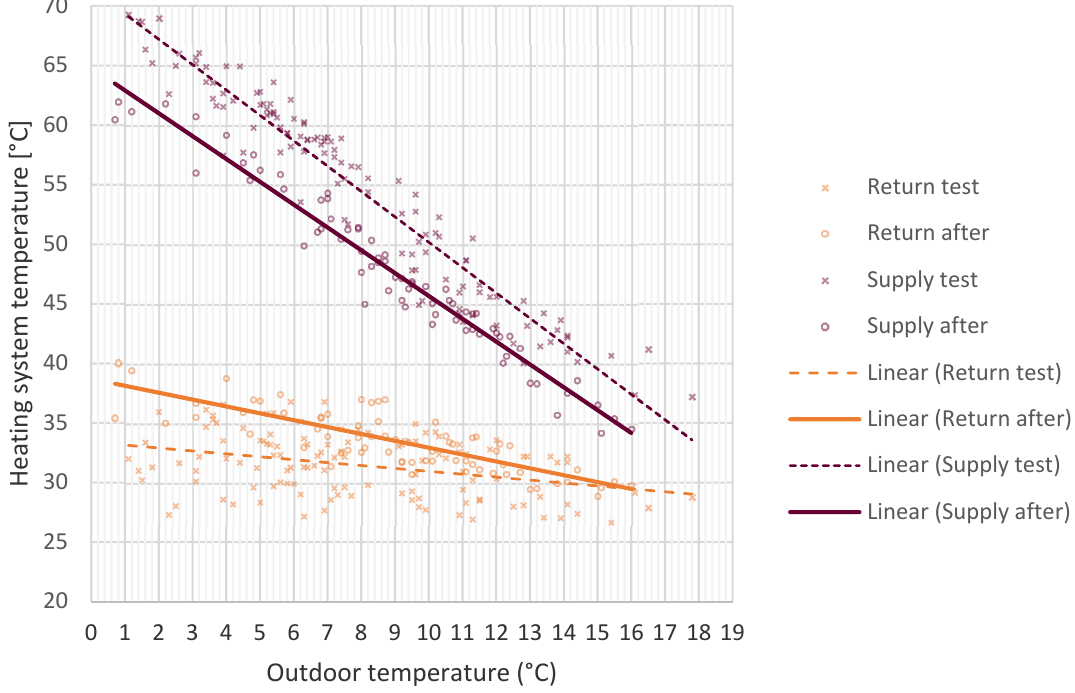
Figure 7. Space heating supply and return temperatures vs. outdoor temperature during the prototype test and during the reference period